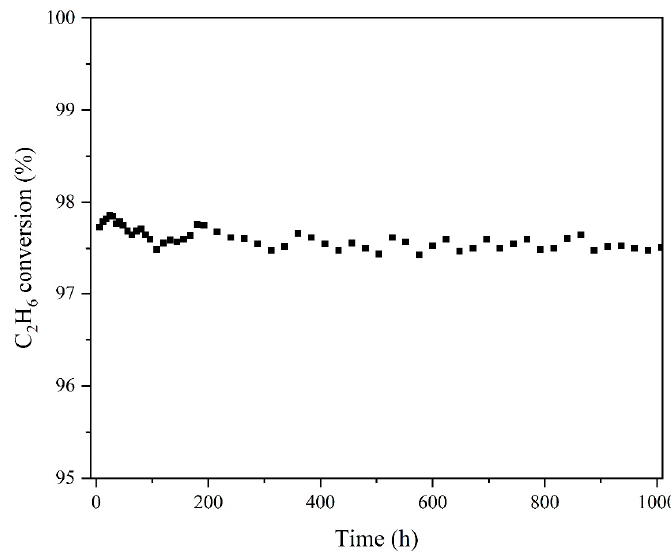
Figure 12. Catalytic efficiency of Pd-1 at 623 K.